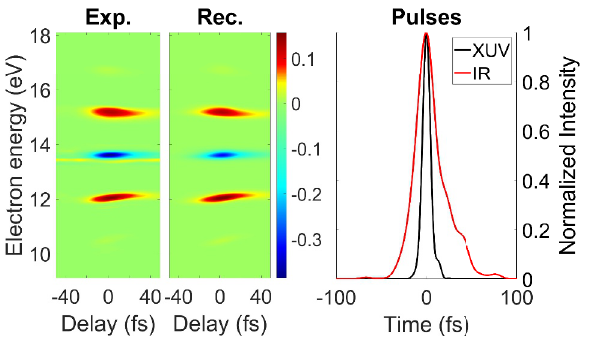
Figure 4. Experimental and reconstruced single-harmonic dif- ferential traces. Despite the simplified model, STRIPE can catch all the features of the experimetnal trace. On the right, we show the reconstructed XUV (black) and IR (red)